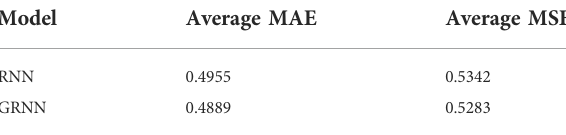
TABLE 1 Comparison of prediction results for Well